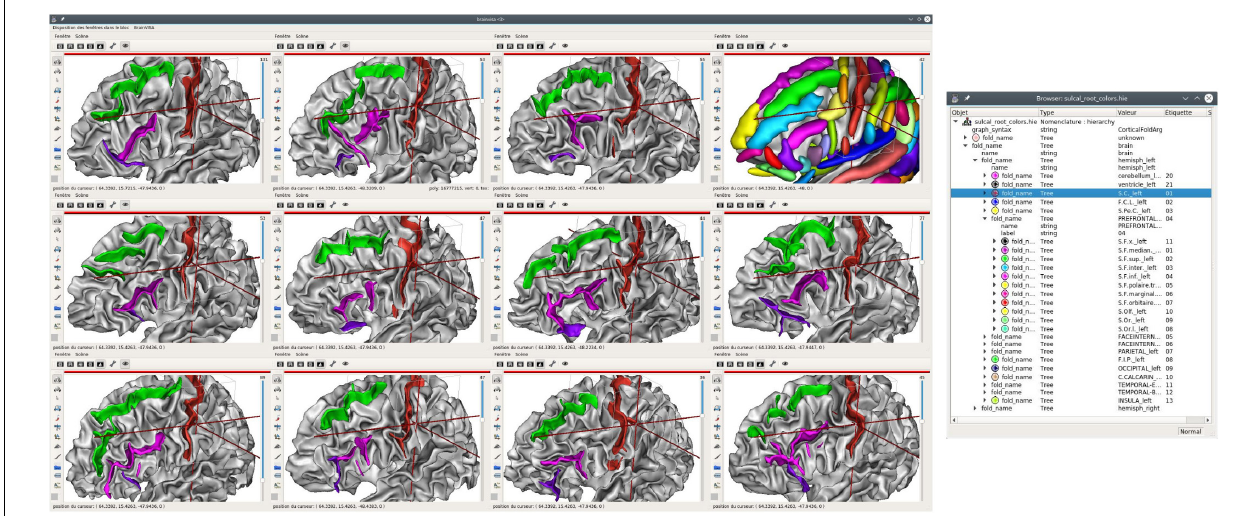
FIGURE 5 | Structural atlas browsing, displaying the same entities on many subjects; here, 11 left hemispheres are displayed, each with 3 sulci: central sulcus (selected, in red), superior frontal (green), and inferior frontal. The latter is made up of two distinct entities, the anterior (purple) and posterior (pink) parts. The sulcal model is also displayed in the upper right 3D view. A structured display of the hierarchical nomenclature is shown on the right. All 3D views are displayed using the same orientation in a common space, although each piece of data lives in its own native coordinate